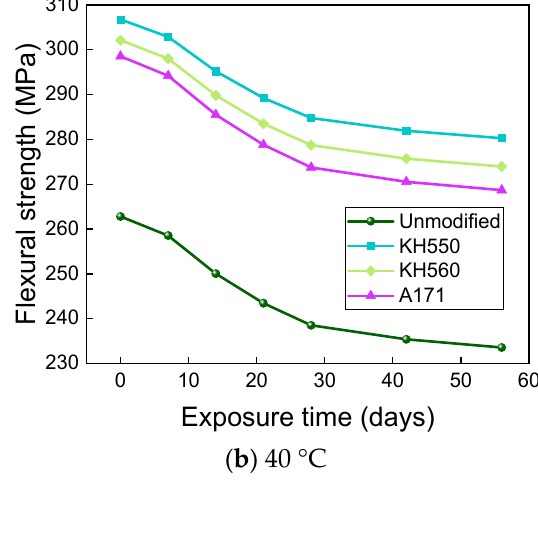
Figure 22. Flexural strength retention in a 3.5% NaCl seawater environment.